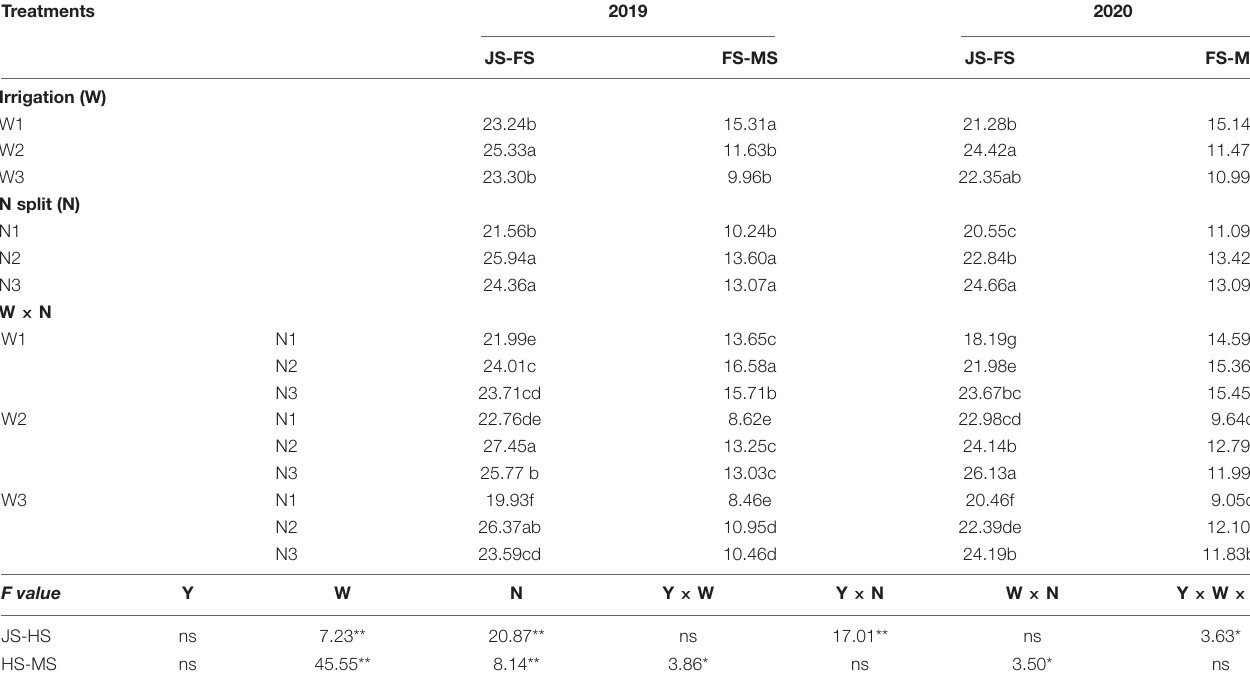
TABLE 6 | Effect of the irrigation methods and N split applications on crop growth rate (CGR).